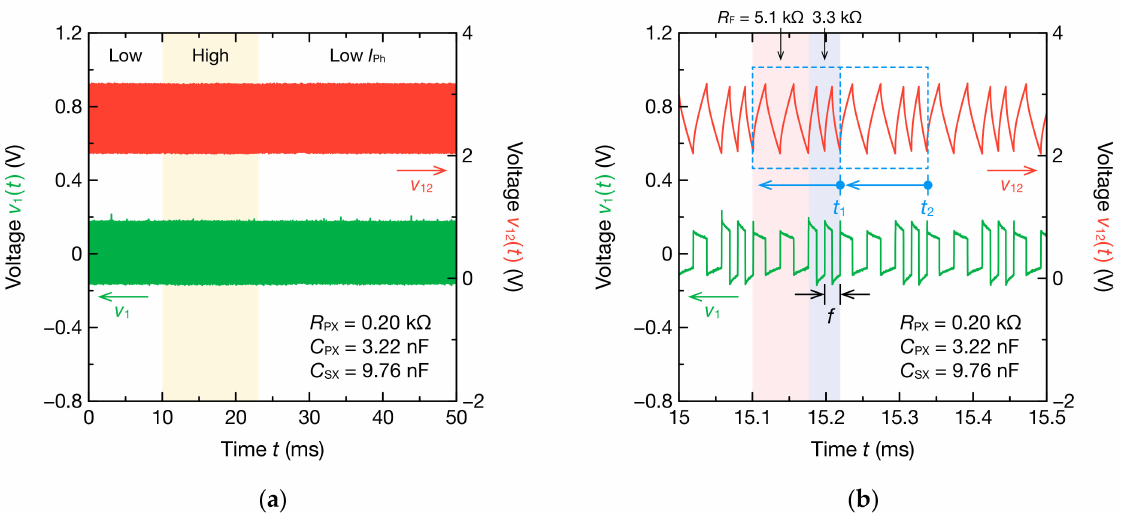
Figure 19. Two-mode oscillation waveforms of v 12 ( t ) and v 1 ( t ) for the nonsinusoidal oscillator incorporating the CdS photocell and circuit elements of the bioimpedance model (Figure 3b): ( a ) full waveform and ( b ) enlarged waveform. The photocurrent I Ph of the photocoupler is changed at 10 and 23 ms. The high and low levels of I Ph are 8.0 and 4.0 mA, respectively. Circuit parameters are estimated for each cycle (blue dashed line). Representative points of time in each cycle are the ends of the cycles such as t 1 and t 2 . The frequency f is the oscillation frequency obtained from the second half cycle of the oscillation waveform at R F = 3.3 k Ω